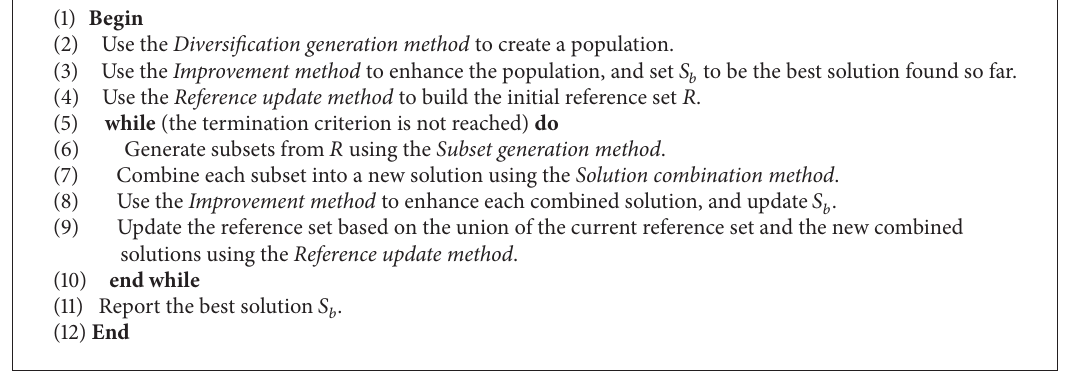
Algorithm 1: Canonical scatter